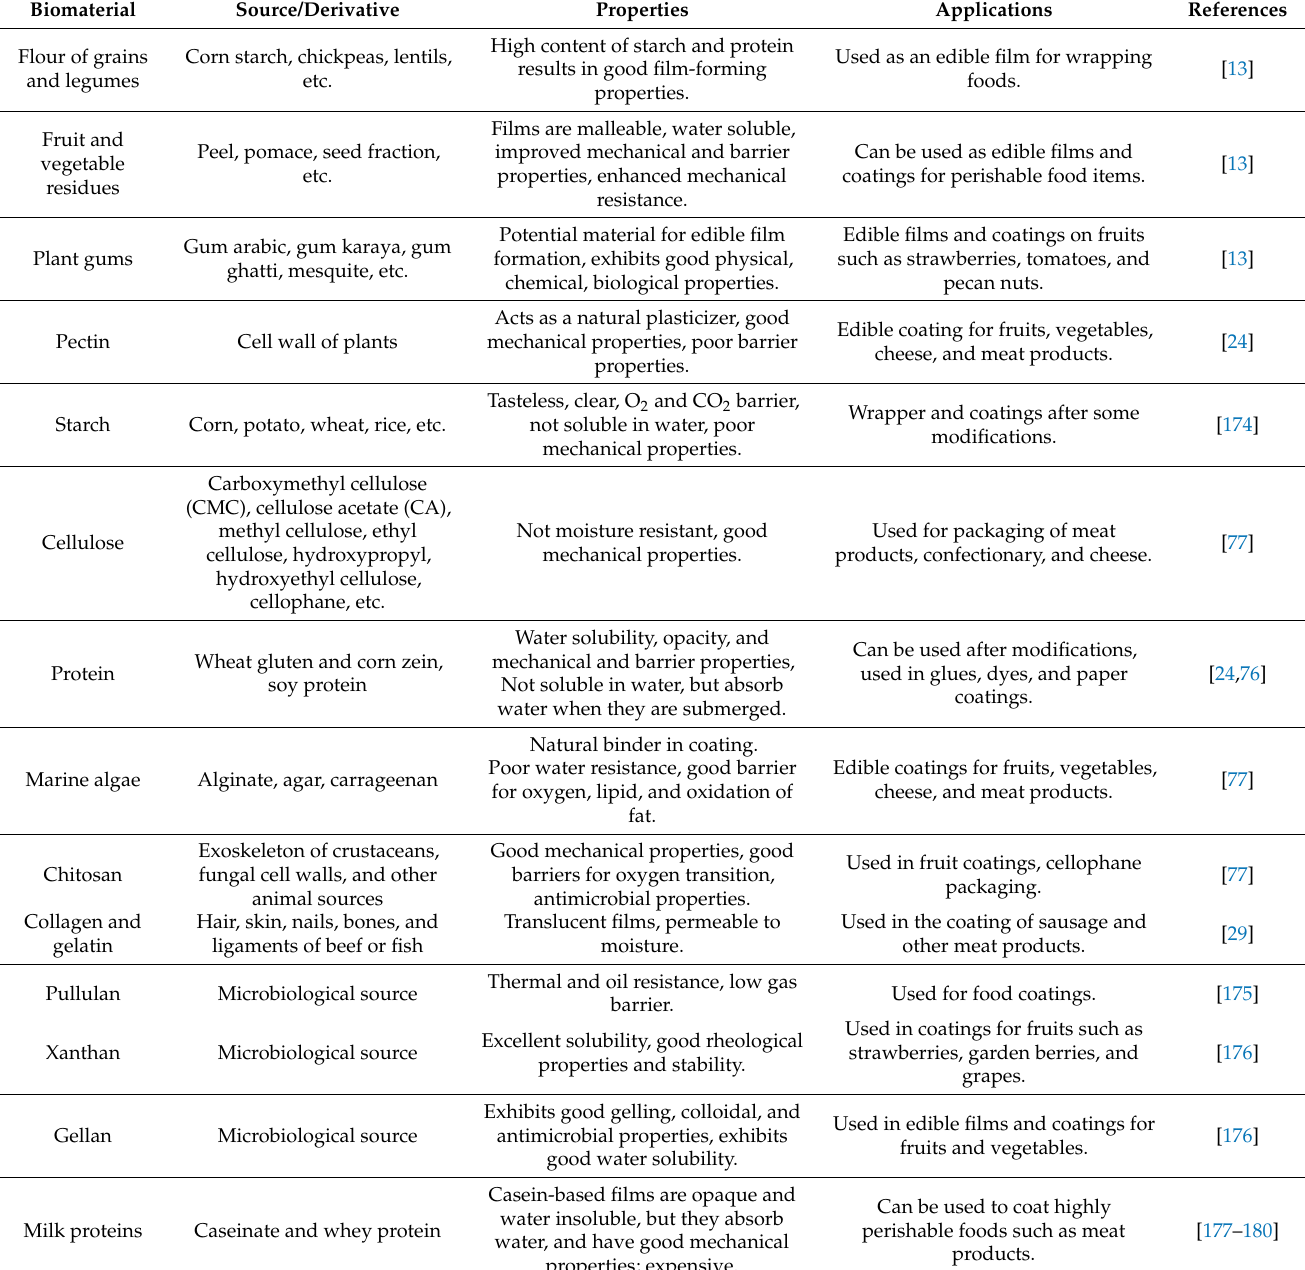
Table 2. Brief summary for biomaterials used in edible